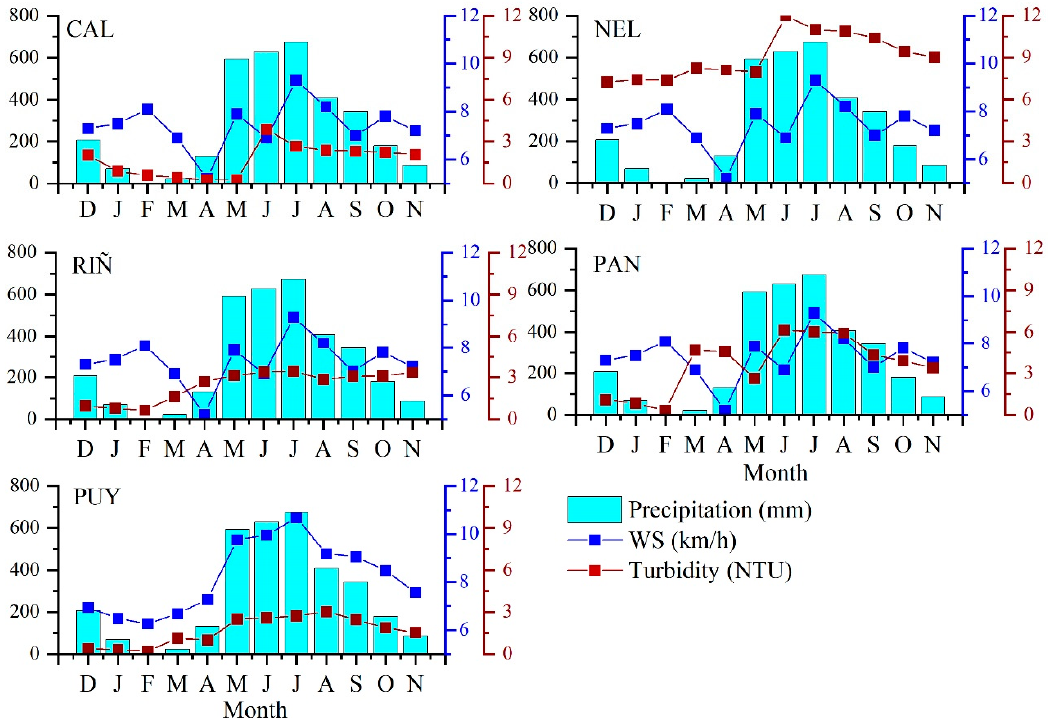
Figure 6. Accumulation monthly rate of precipitation, average monthly wind speed, and temperature in all study lakes and estimated turbidity.